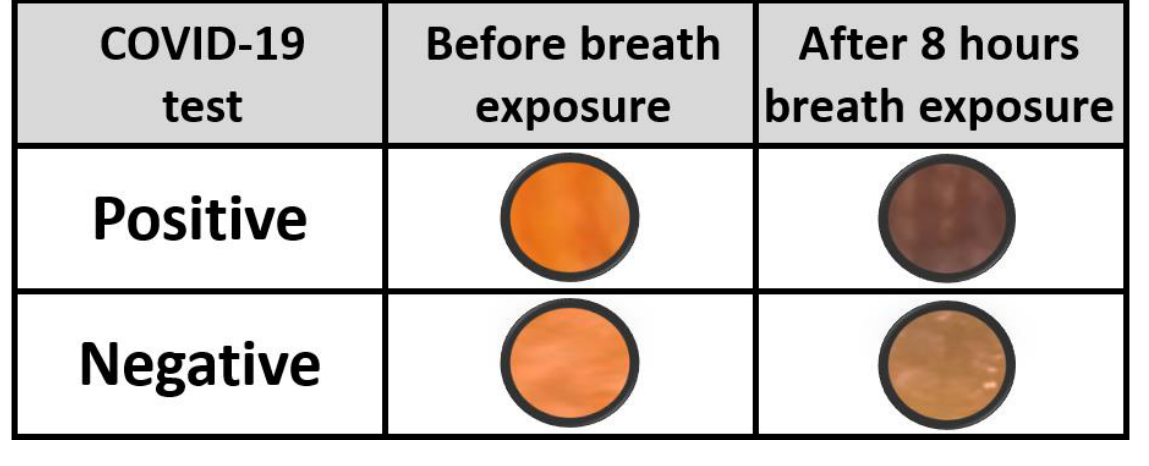
Figure 5. Ethanal-sensitive solution color change reactivity upon exposition to COVID-19 negative and positive tested persons’ breath.